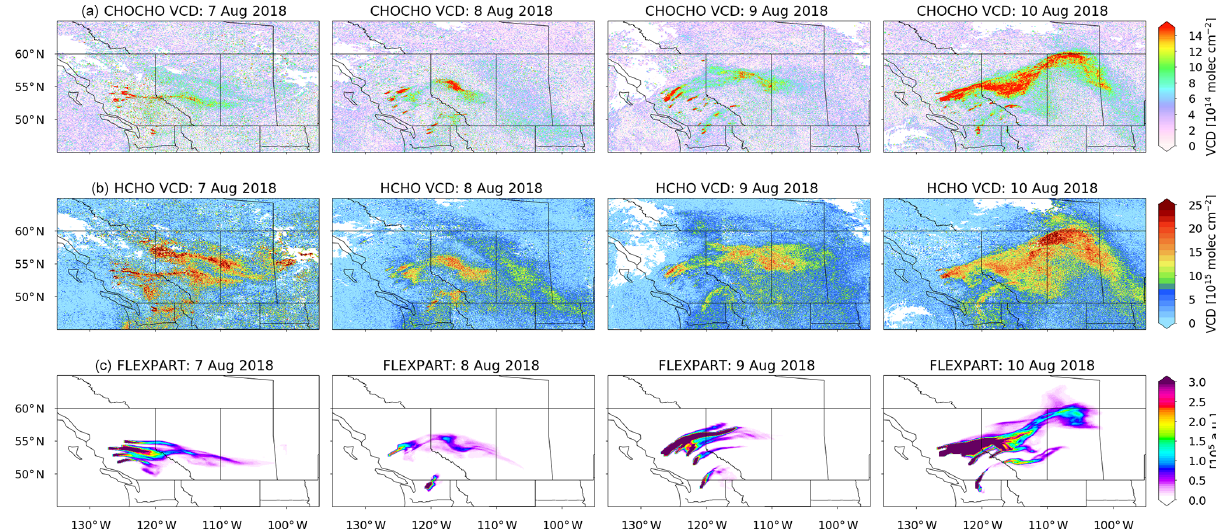
Figure 4. (a, b) Daily CHOCHO and HCHO VCDs retrieved from S5P measurements for the period 7 to 10 August 2018. (c) Distribution of a tracer with a lifetime of 14.4h simulated with FLEXPART for the same period. The CHOCHO in the plume decreases on average from 3 × 10 15 to 3 × 10 14 molec . cm − 2 , while the HCHO has a different variation in the plume, but at the end of the plume it decreases from 3 × 10 16 to 1 × 10 16 molec . cm − 2 . The FLEXPART tracer column decreases from 3 × 10 6 to 0 . 3 × 10 6 for this specific effective lifetime of